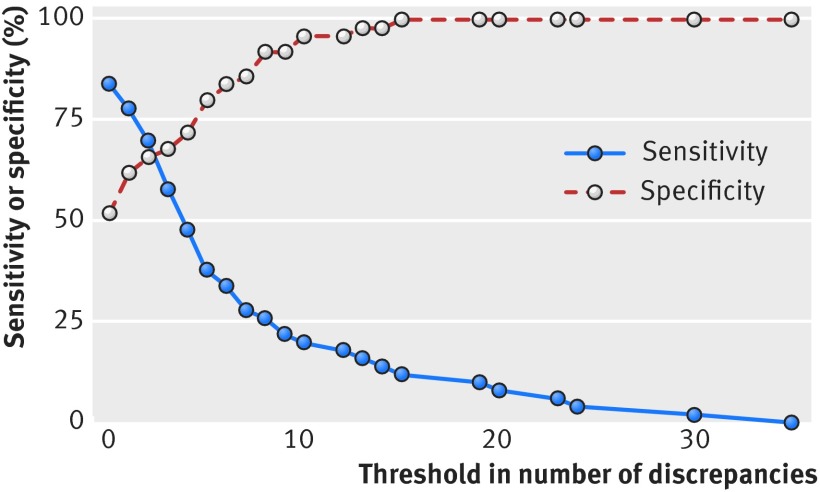
Fig 3 Sensitivity and specificity of the total number of discrepancies in a trial report exceeding a threshold, and retraction